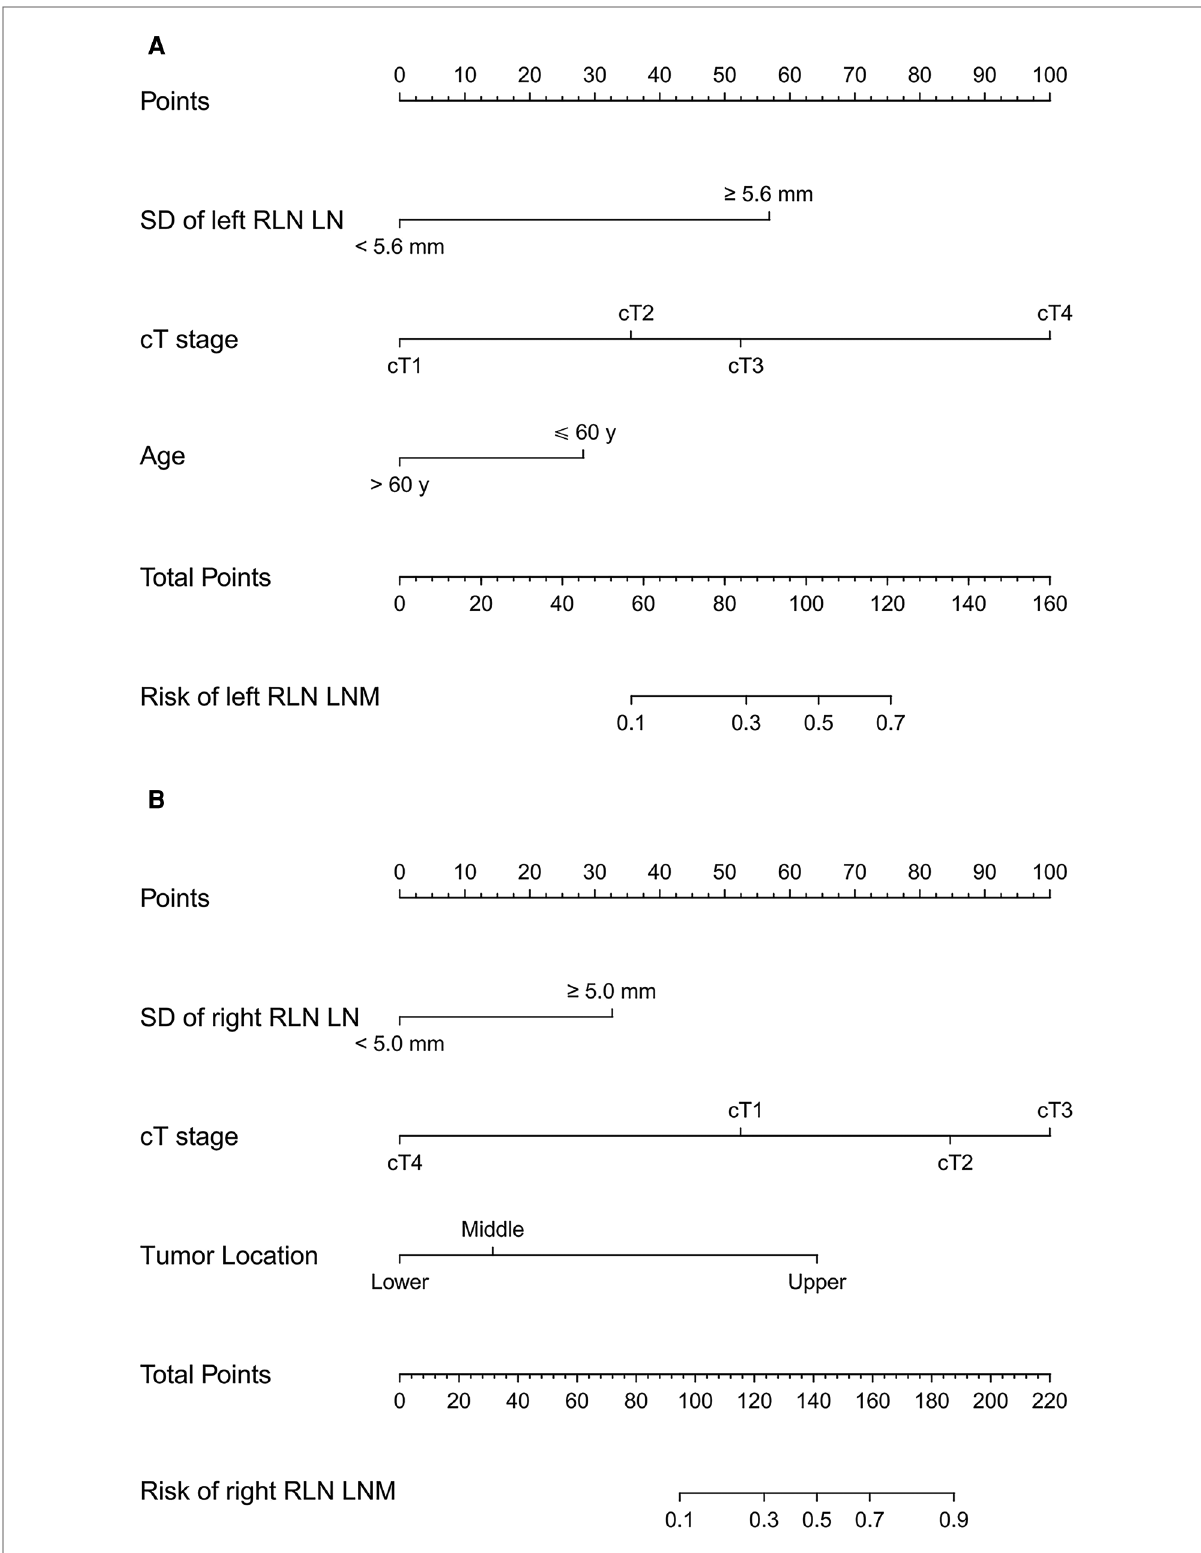
FIGURE 3 Traditional nomograms for left and right RLN LNM prediction. The nomogram for left RLN LNM incorporated the SD of left RLN LN, cT stage, and age ( A ). The nomogram for right RLN LNM incorporated the SD of right RLN LN, cT stage, and tumor location ( B ). RLN LNM, recurrent laryngeal nerve lymph node metastasis; RLN LN, recurrent laryngeal nerve lymph node; SD, short diameter; cT stage, clinical T